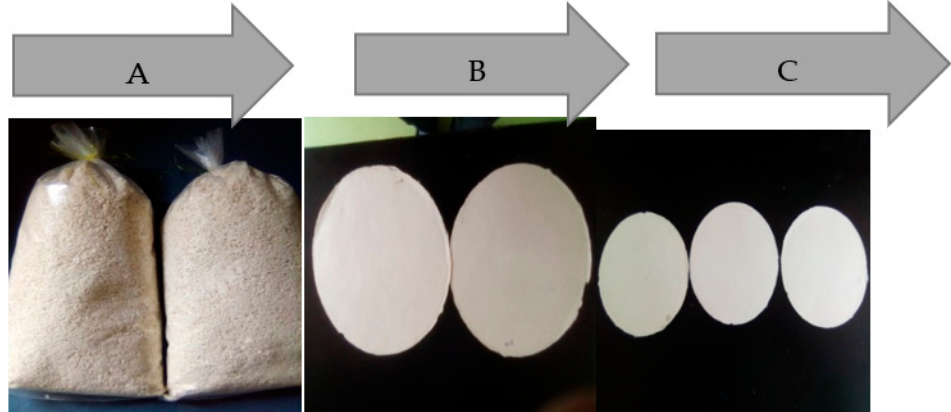
Table 5. Physical properties of the pulp sheet in the present study and other raw biomass materi-